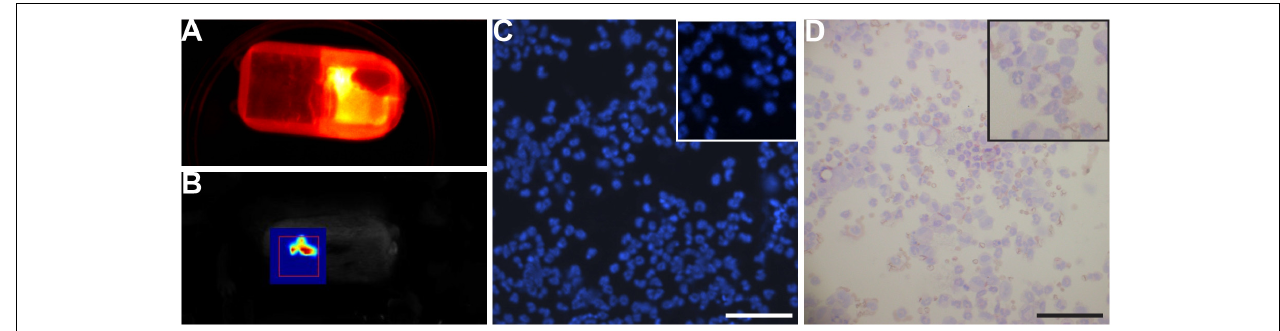
FIGURE 5 | Viability of cells. (A,B) Near-infrared fluorescence imaging. (A) The device containing HEK-NirFP cells before implantation. Cells were detected. (B) The device containing HEK-NirFP cells at 2 weeks after implantation. HEK-NirFP cells were still detectable after 2 weeks of implantation. (C,D) DAPI (C) and hematoxylin-eosin staining (D) of cells in the device collected during device removal. Cells were still present in the device, and the shape/morphology was normal. Scale bar = 200 µ